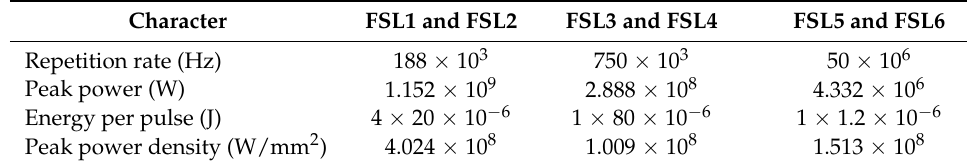
Table 5. Summary of energetic